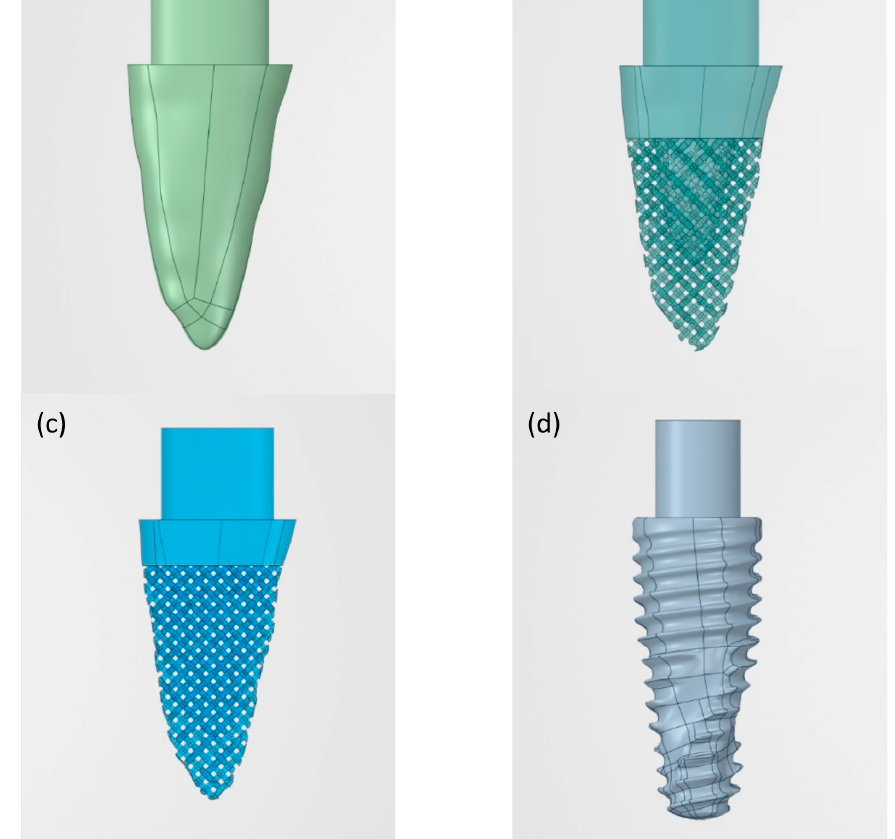
Figure 1. CAD models of four implant designs: ( a ) Solid root-analog implant; ( b ) Solid and porous root-analog implant; ( c ) Porous root-analog implant; ( d ) Screw-type implant (control).